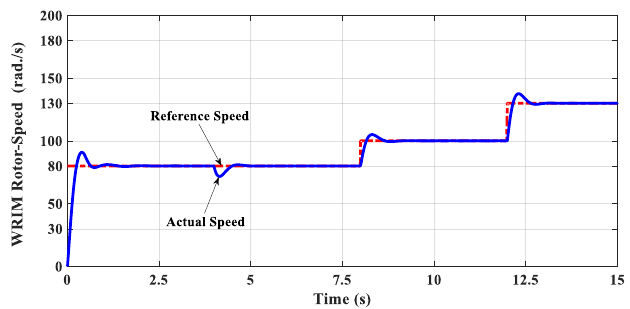
Figure 5. Command speed response and its corresponding actual value.